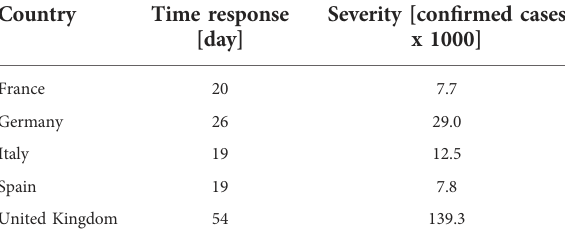
TABLE 3 Time response and severity of the